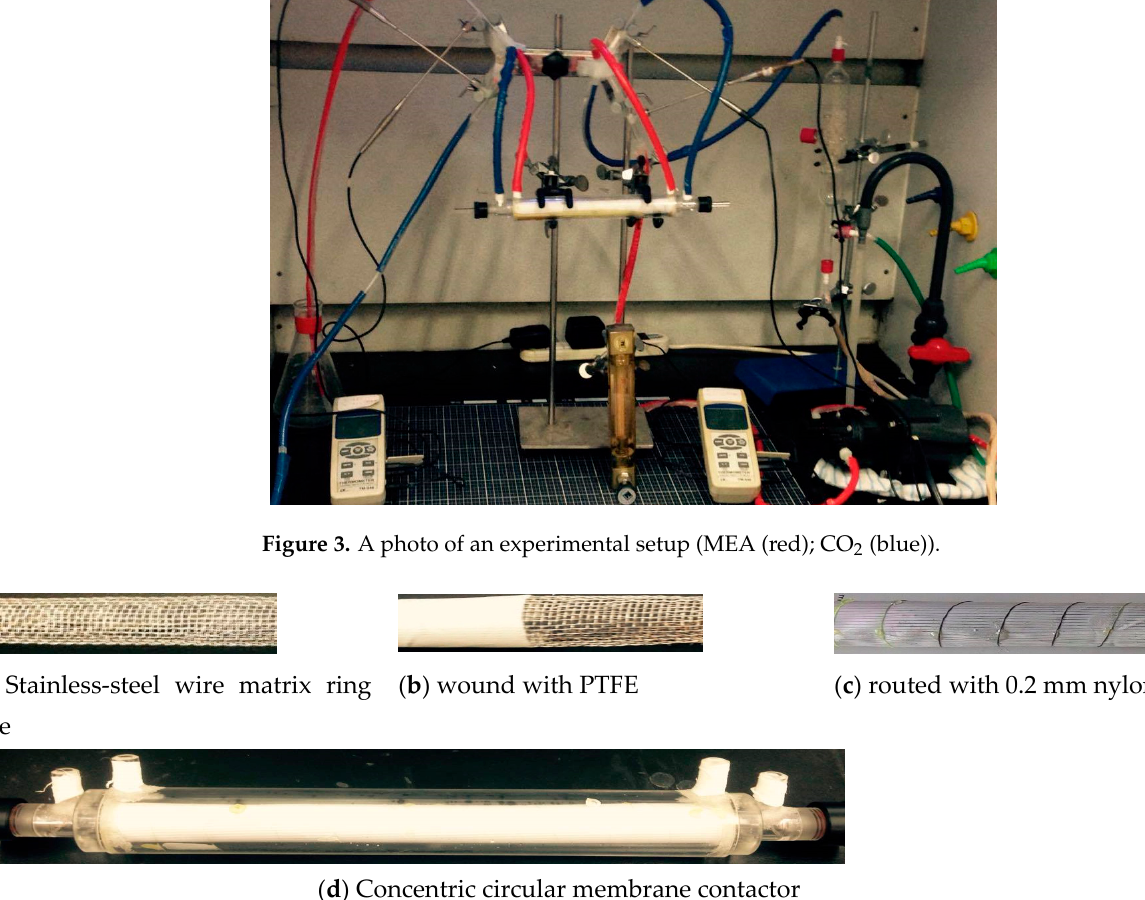
Figure 2. Experimental apparatus of the concentric circular gas/liquid membrane contactor system. ( A ) Concentric circular membrane contactor; ( B ) Flow meter; ( C ) Pump; ( D ) Mass flow controller; ( E ) Mixer; ( F ) Gas cylinder; ( G ) Thermostatic tank; ( H ) Chromatograph; ( I ) Beaker; ( J ) Monitor; ( K ) Temperature indicator. Table 2. Specifications and parameters of the experimental runs.